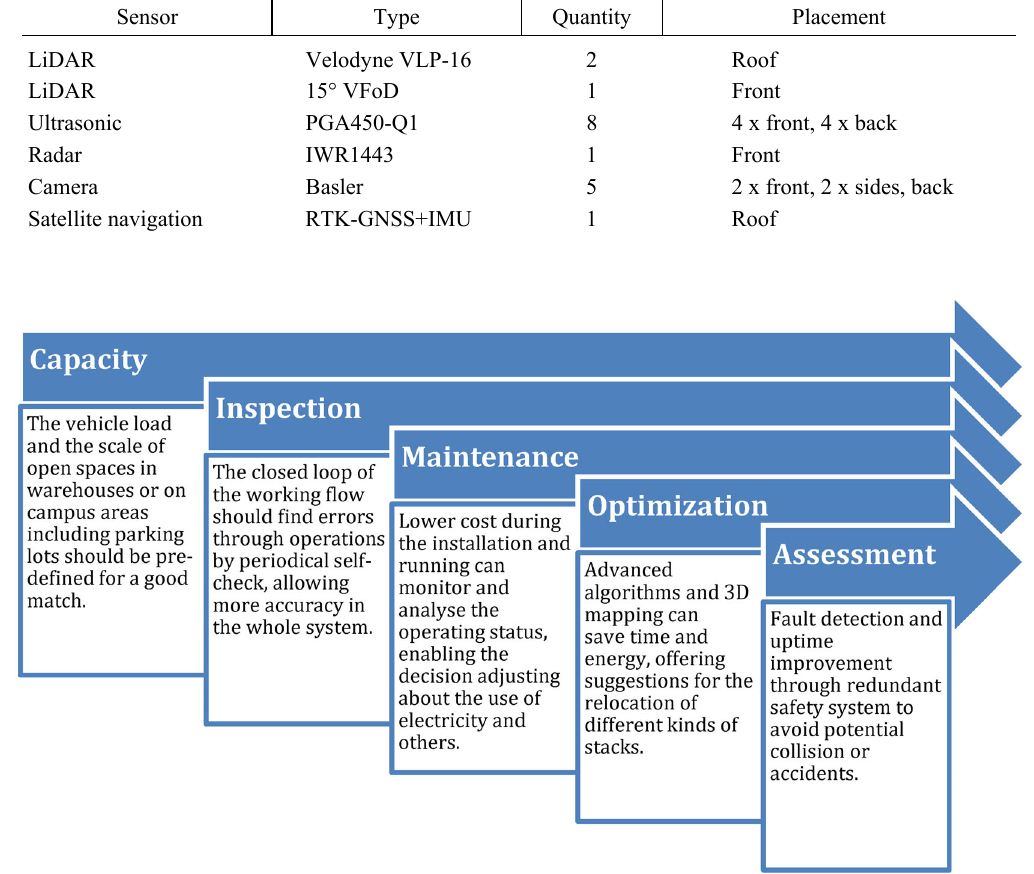
Table 2. Sensors used in ISEAUTO last mile shuttle bus